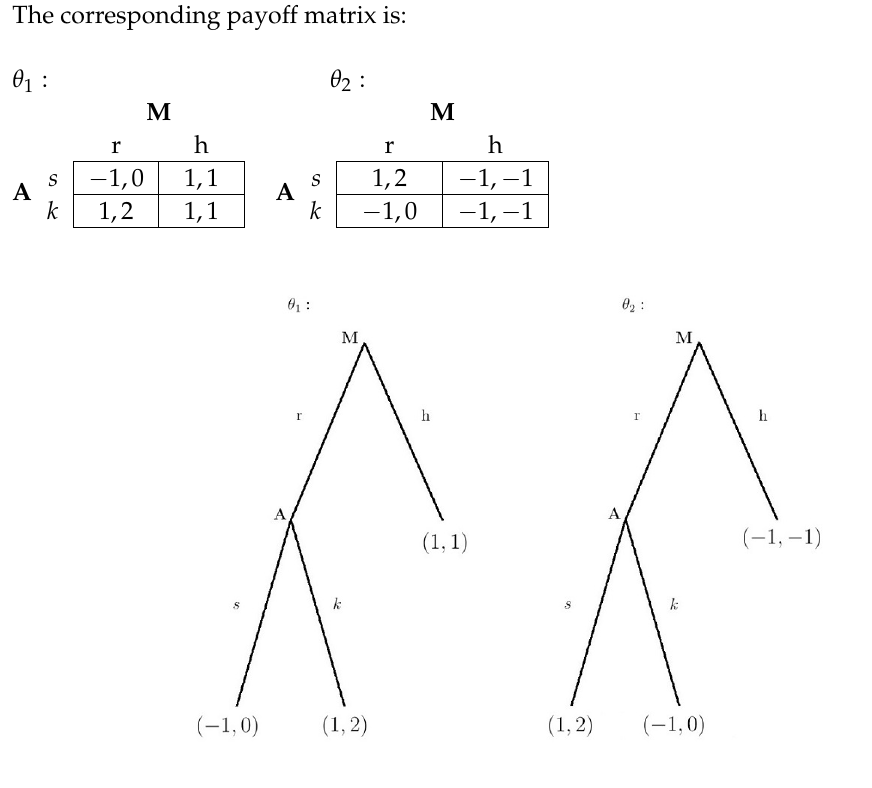
Figure 1. Case 1